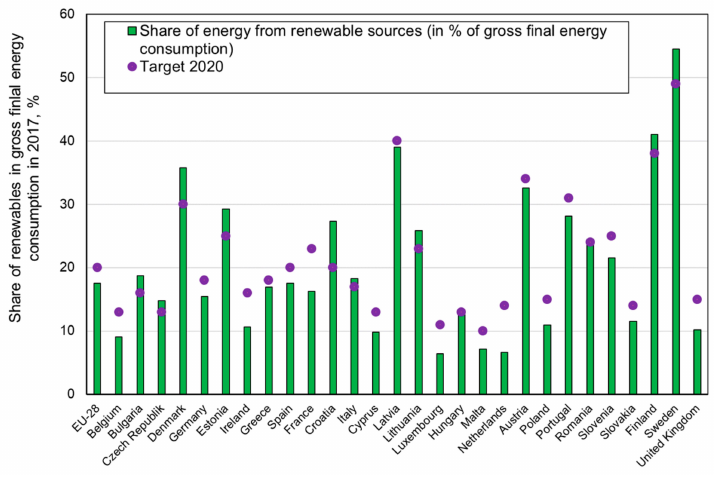
Figure 1. Share of energy from renewable energy sources in % of gross final energy consumption in the EU (own study based on data from [35–37]).